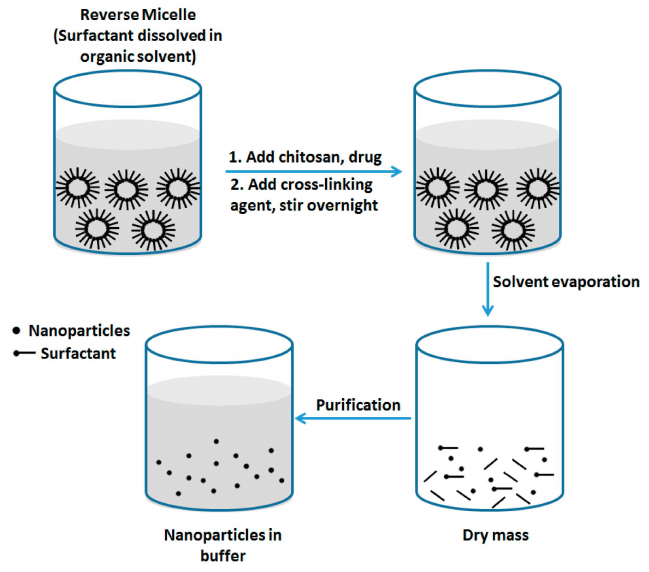
Figure 6. Preparation of chitosan NPs by reverse micellar